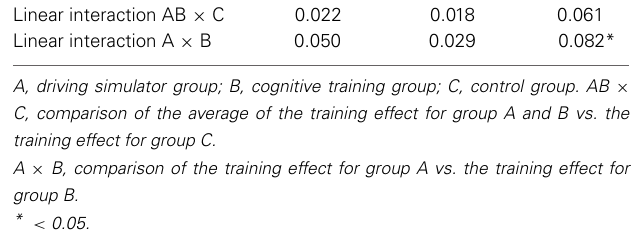
FIGURE 3 | Group means of overall on-road performance before and after participation broken down for the three groups. Error bars in plots indicate the standard error of the mean. Please note dimension is arbitrary. Note: n.s. , not significant; ∗ <